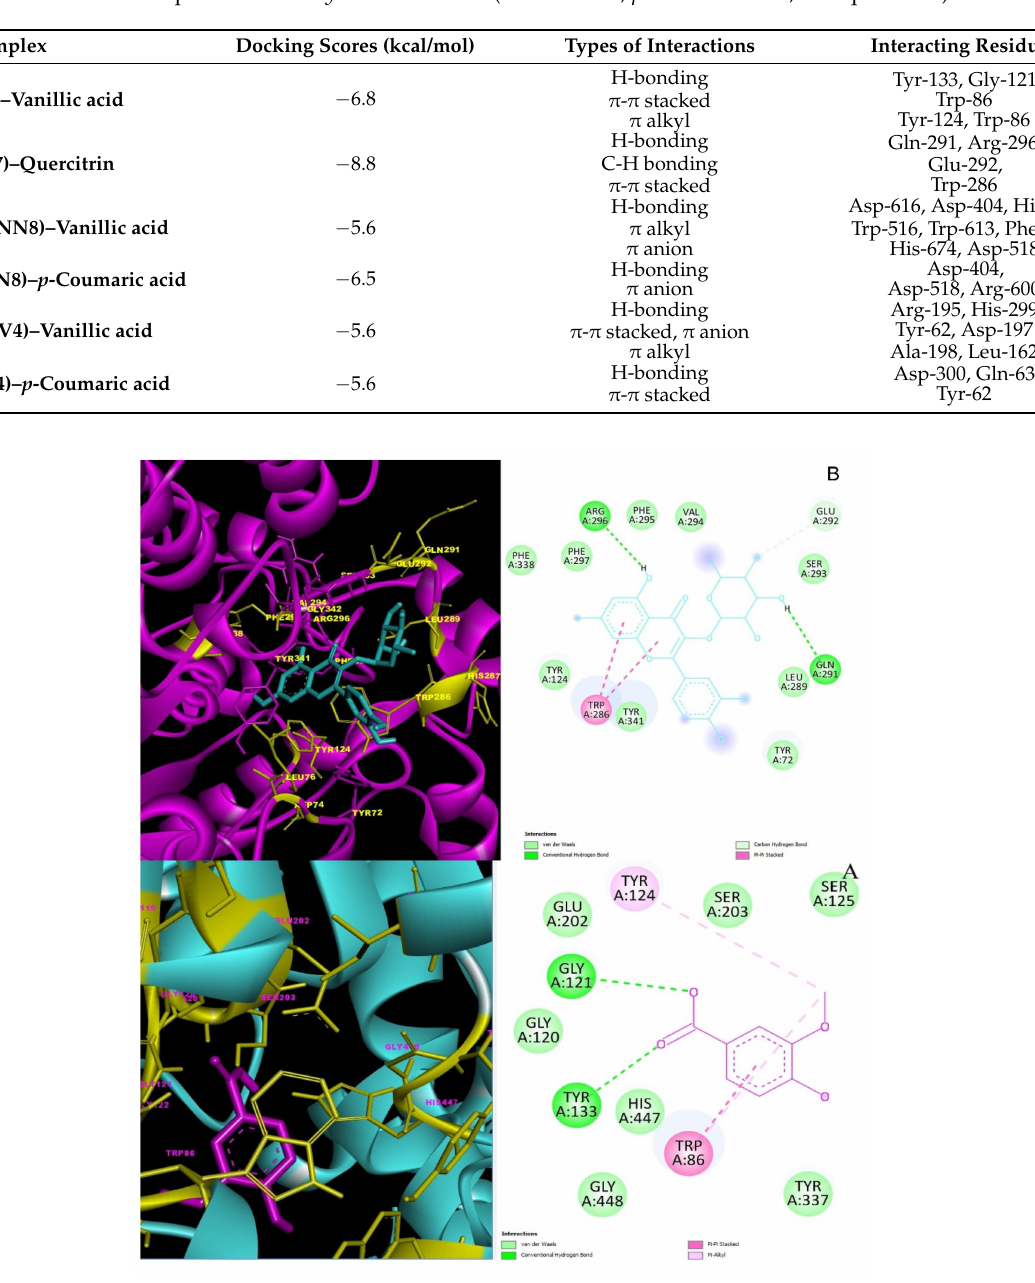
Table 6. Molecular interactions of the AChE, α -amylase, and α -glycosidase with the major phenolic compounds of Dactylorhiza osmanica (vanillic acid, p -coumaric acid, and quercitrin).